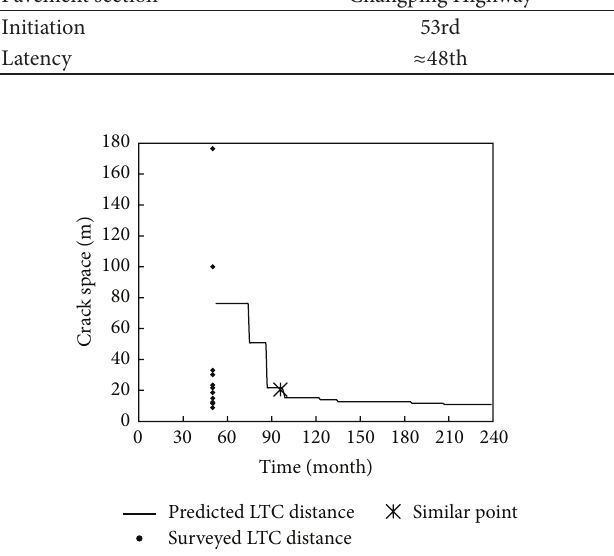
Figure 12: Predicted thermal cracking versus survey thermal crack- ing on Haxihuan